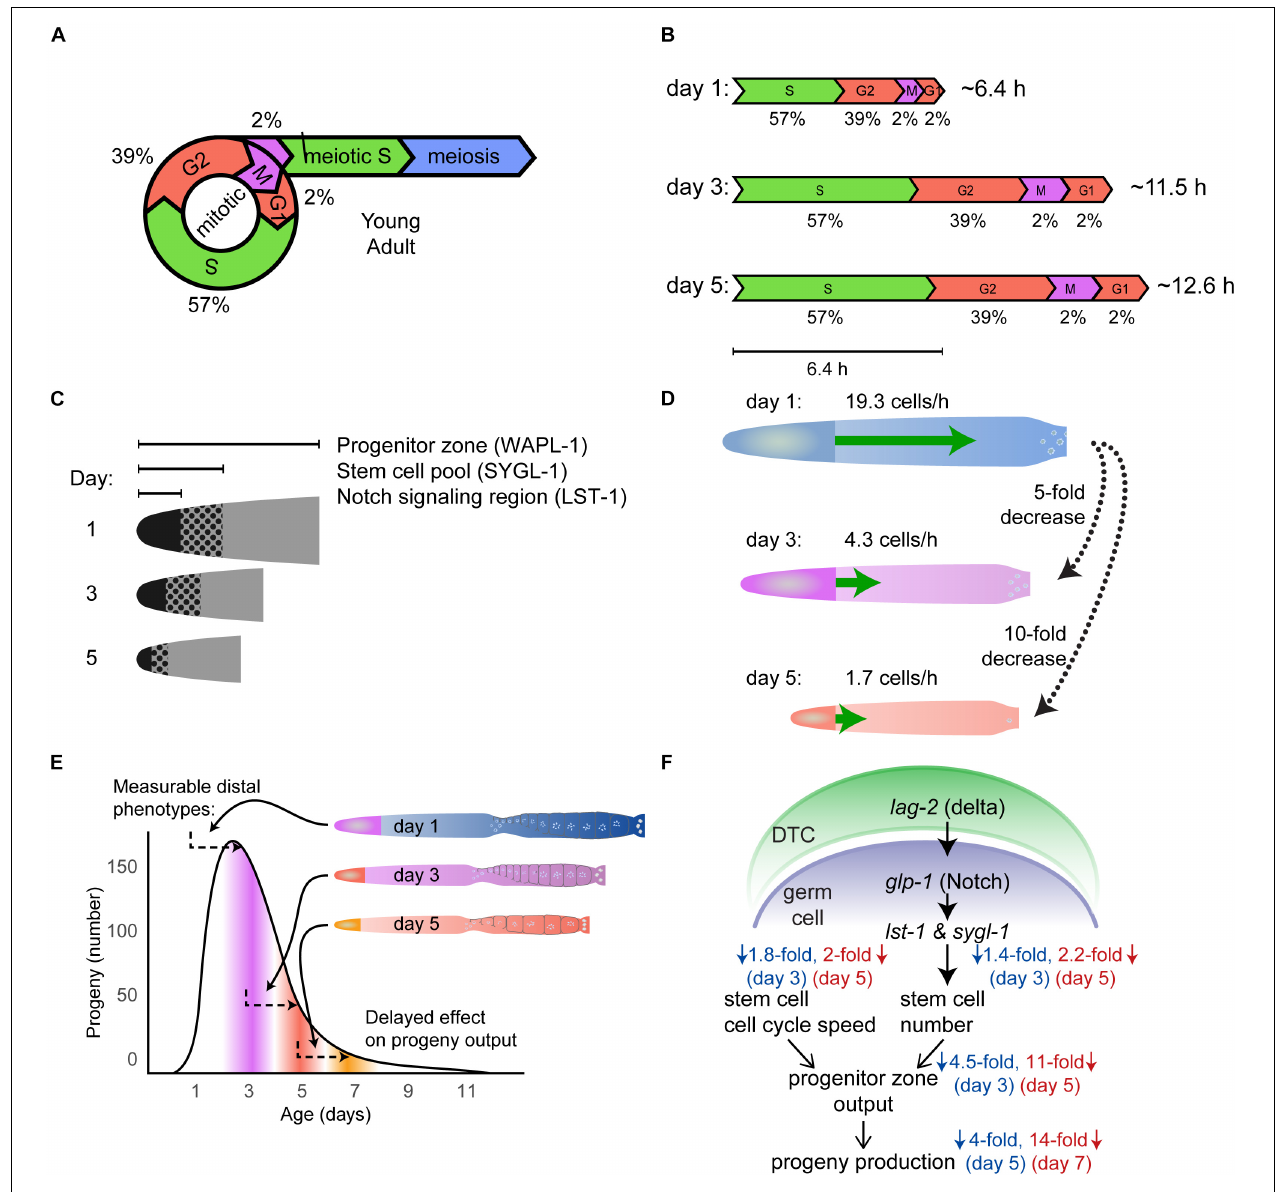
FIGURE 6 | Population-wide, age-related degenerative changes in the germ line. (A) Schematic of the mitotic cell cycle and meiotic entry of young adult wild-type germ cells, including duration of time in each phase expressed as a percent (Fox et al., 2011). Adapted from Kocsisova et al. (2019). (B) The duration of the cell cycle increases with age in mated wild-type hermaphrodites. The scale diagram summarizes the duration of different phases of the cell cycle in day 3 and 5 animals compared to day 1 animals. The values below indicate the percentage of time in each phase, whereas the values on the right indicate the total cell cycle duration time. Adapted from Kocsisova et al. (2019). (C) The schematic shows that the size of the Notch signaling region, stem cell pool, and the progenitor zone (PZ) shrinks with age. Notch signaling was visualized by LST-1 labeling, the stem cell pool was visualized by SYGL-1 labeling, and the progenitor zone was labeled with WAPL-1 antibodies in day 1, 3, and 5 germ lines. Adapted from Kocsisova et al. (2019). (D) The schematic displays the age-related decrease in the rate of meiotic entry (green arrow) in the germ line of mated wild-type hermaphrodites. Day 5 and 3 germ lines show a 10-fold and 5-fold decrease, respectively, compared to day 1 germ lines. Adapted from Kocsisova et al. (2019). (E) The schematic shows that changes in the distal germ line correlate with changes in the progeny production curve about 2 days later (arrows). The size of the germ line and the progenitor zone (PZ) decreases before the progeny production declines. The PZ cells need two or more days to become oocytes and be laid as eggs. Therefore, age-related changes such as the shrinking of the germ line and PZ affect progeny production with a delay. Adapted from Kocsisova et al. (2019). (F) Summary and model of reproductive aging in C. elegans . Adapted from Kocsisova et al.